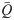
Effect of transmural pressure (via pe).Q¯ vs. external pressure at ΔP = 3, 10, 16 cmH2O for branching networks with nv = 2 (dot-dashed), nv = 4 (solid), and nv = 8 (dotted). The top axis indicates transmural pressure. Peak flow rate occurred at higher values of peas pressure difference increased. Inlet pressure pa was constant and equal to 6 cmH2O.